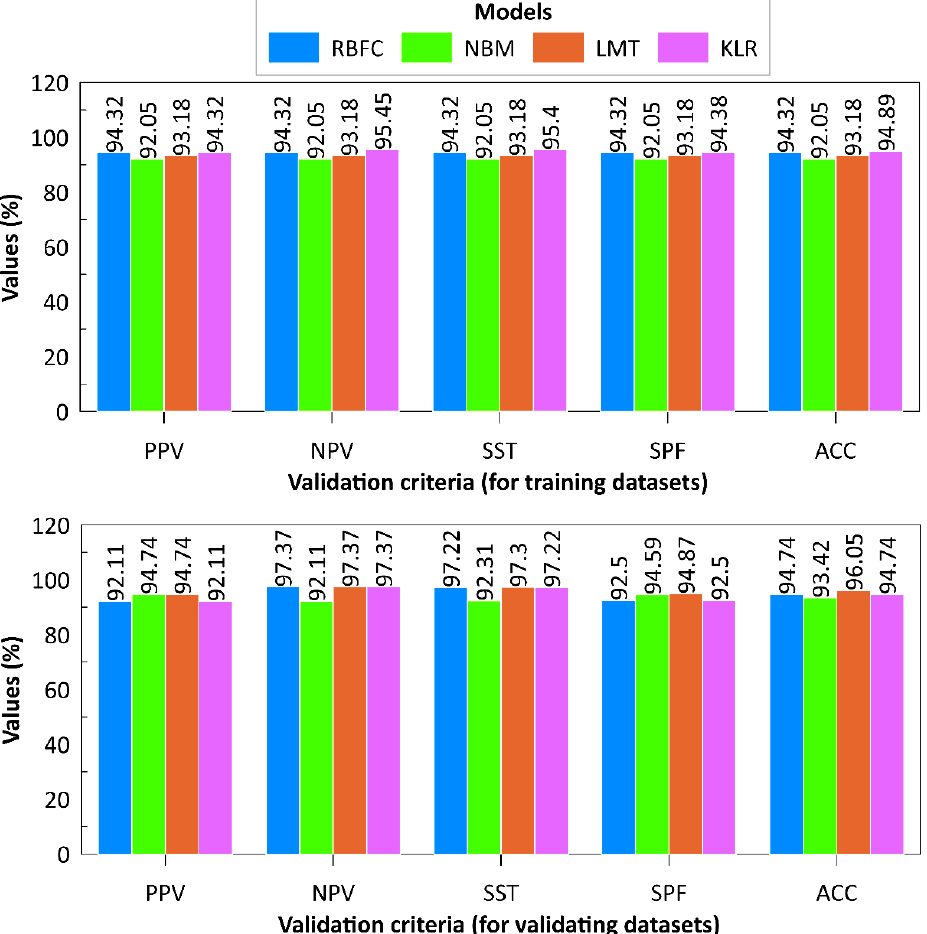
Figure 4. Value of statistical measures of the models.